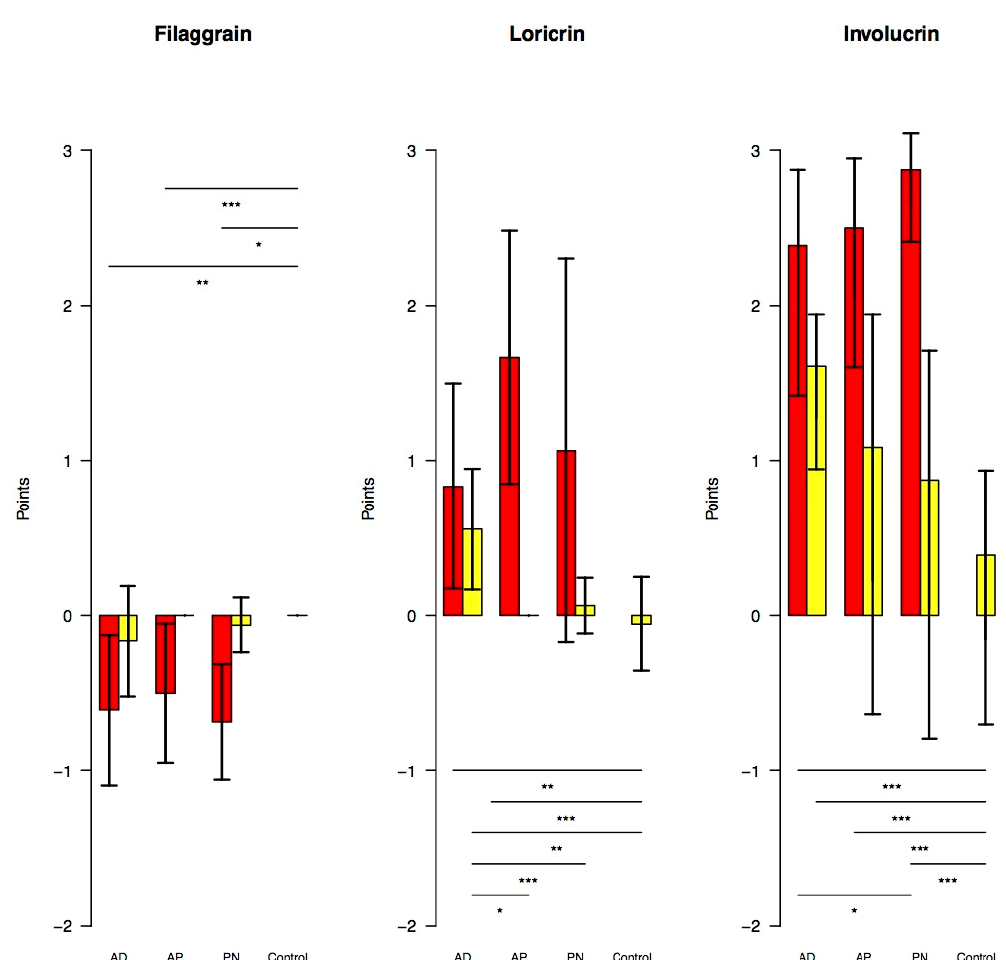
Figure 3. Expression of filaggrin, loricrin and involucrin in lesional (red) and non-lesional (yellow) skin (bar plots with standard deviation). p -value: * p < 0.05, ** p < 0.01, *** p < 0.001. AD: classic atopic dermatitis; AP: atopic prurigo; PN: non-atopic prurigo nodularis.